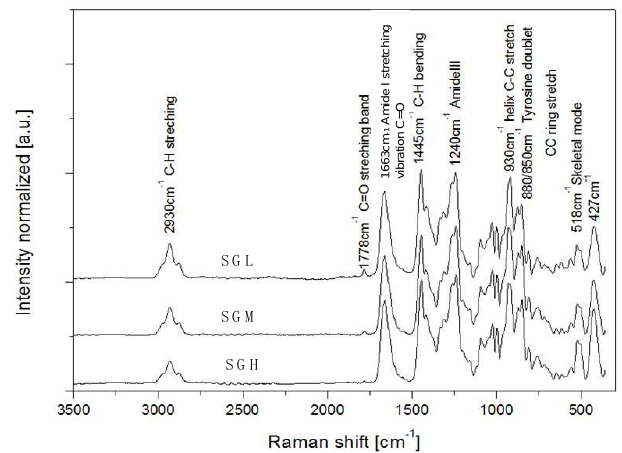
Figure 2. Raman spectroscopy of SG samples with controlled molecular weight.